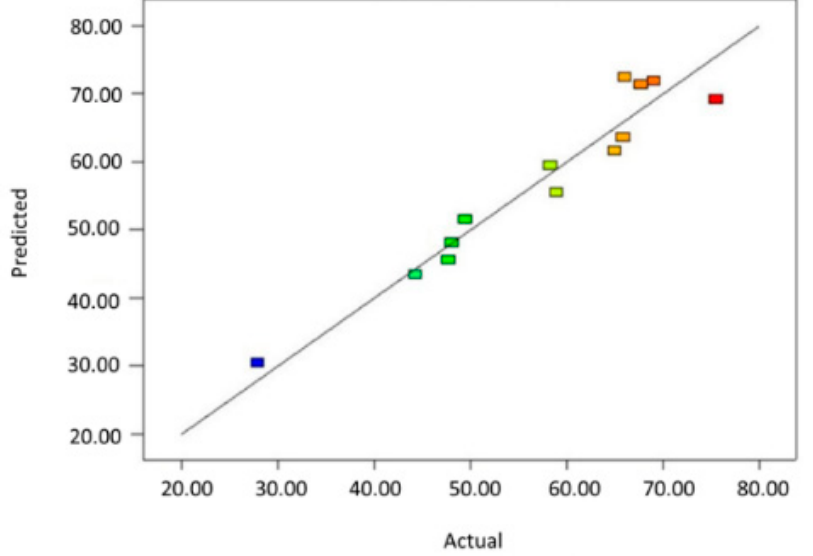
Figure 9. Residual plots calculated from RSM graphs for the EndoPGase activity exhibited by the isolated bacterial strain of B. subtilis in repose to pH, inducer-substrates, and inducer-substrates’ concentration where; blue, green, light red, and red color squares show minimum, medium, and the maximum enzyme activity response respectively.